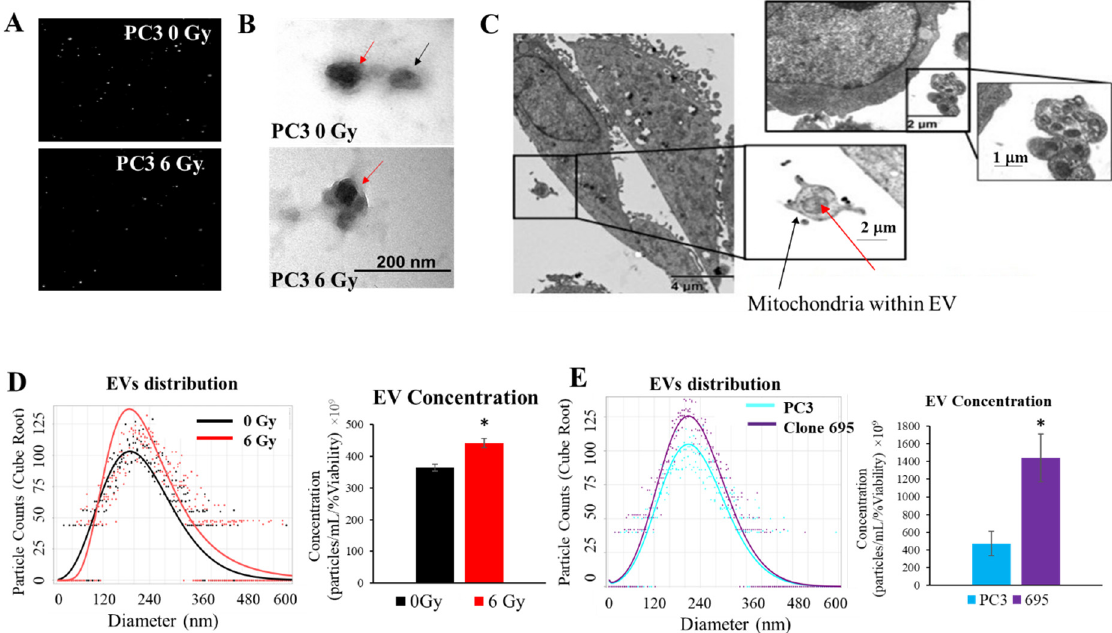
Figure 4. RT activates EVs production . ( A ) NTA images of particles by Zeta View Particle Metrix. ( B ) TEM images of EVs isolated from PC3 cells 0 Gy and 6 Gy. Red arrows denote membrane (outer gray color) and inner cargo (darker gray color). ( C ) EVs carrying “mitochondria-like structures” as cargo upon RT in PC3 cells. Black arrow indicates an Extracellular Vesicle and the red arrow indicates Mitochondria within the vesicles . ( D ) EV count and EV population isolated from PC3 cells at 0 Gy and 6 Gy. ( E ) EV count and distribution isolated from PC3 cells and clone 695 cells, post 72 h after seeding Margin Model from negative binomial overlaid with observed values (Predict values without random effects). * p -value < 0.05.